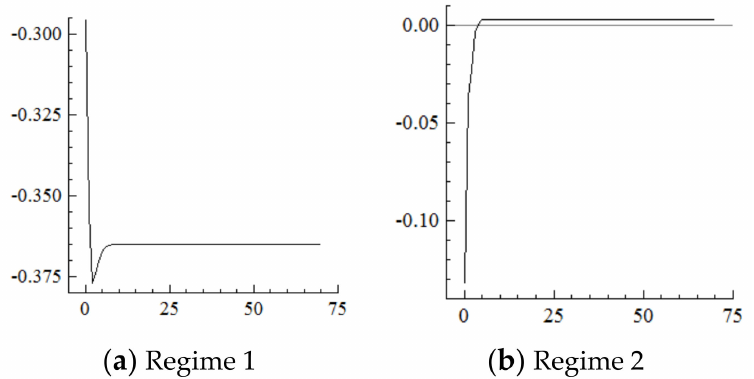
Figure 14. Cumulative Impulse Response of Industrial Structure Upgrading to Export Upgrading